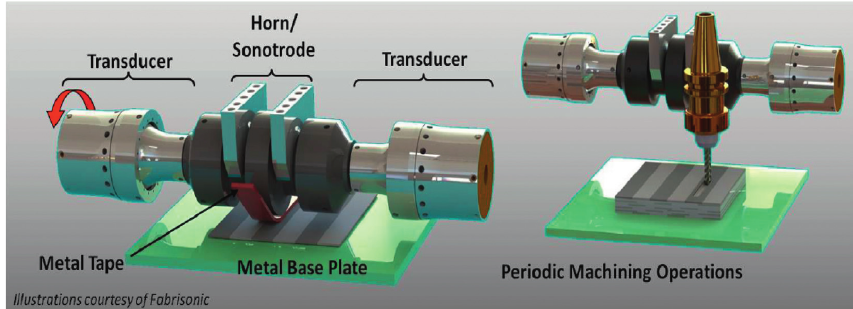
Figure 1: UAM process and components illustration by Fabrisonic© [1].